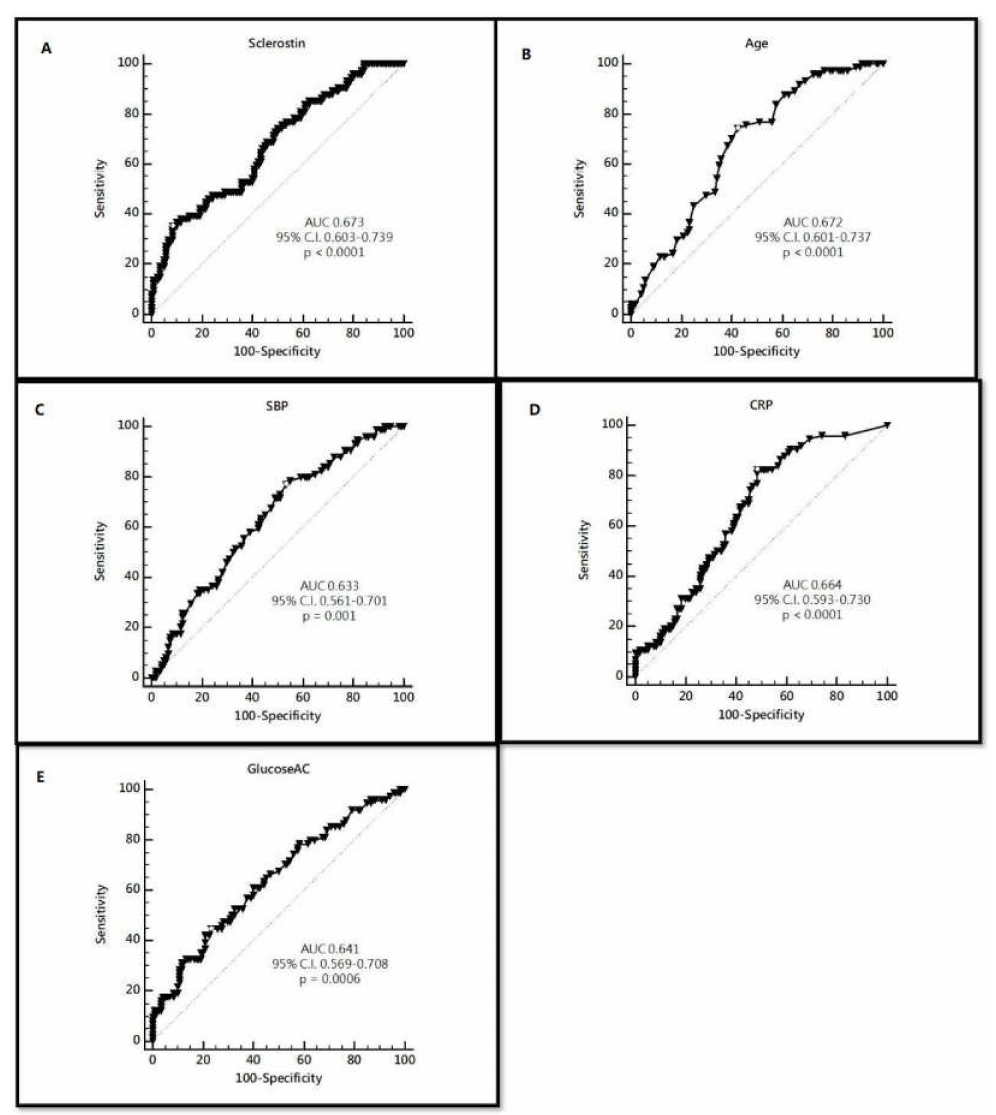
Figure 3. ROC curve and cut-o ff level of ( A ) sclerostin, ( B ) Age, ( C ) SBP, ( D ) CRP, and ( E ) fasting glucose to predict high arterial sti ff